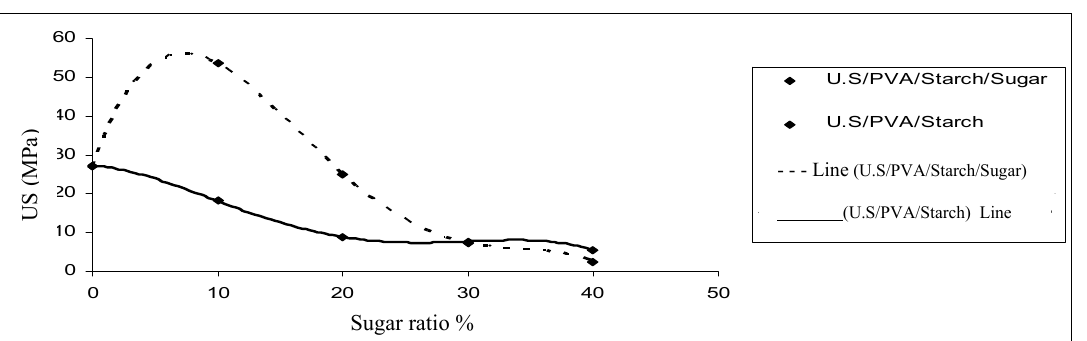
Fig.7: The ultimate strength against the starch, and sugar ratio.